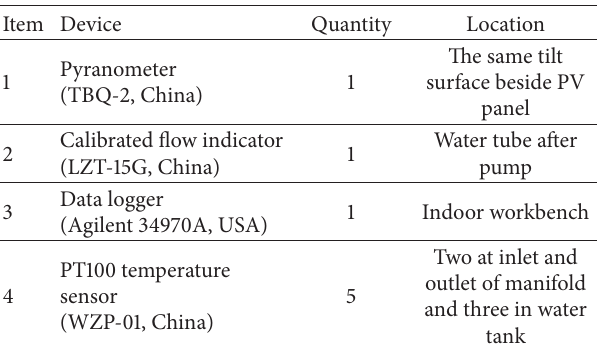
Table 1: List of testing